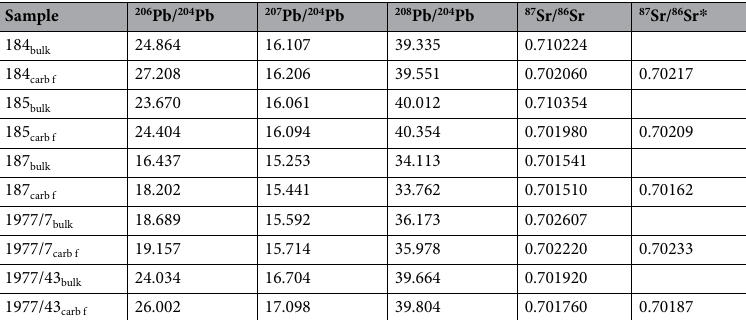
Table 1. Lead and Sr isotopic ratios of Archaean limestones with the low 87 Sr/ 86 Sr of coeval seawater. * Carbonate fraction data from refs 22,23 , normalized to NBS987 87 Sr/ 86 Sr = 0.710254. Analytical errors are ± 0.000018 for 87 Sr/ 86 Sr, ± 0.002 for 206 Pb/ 204 Pb, ± 0.003 for 207 Pb/ 204 Pb and ± 0.010 for 208 Pb/ 204 Pb; 2 σ precisions for individual Sr and Pb measurements are better than